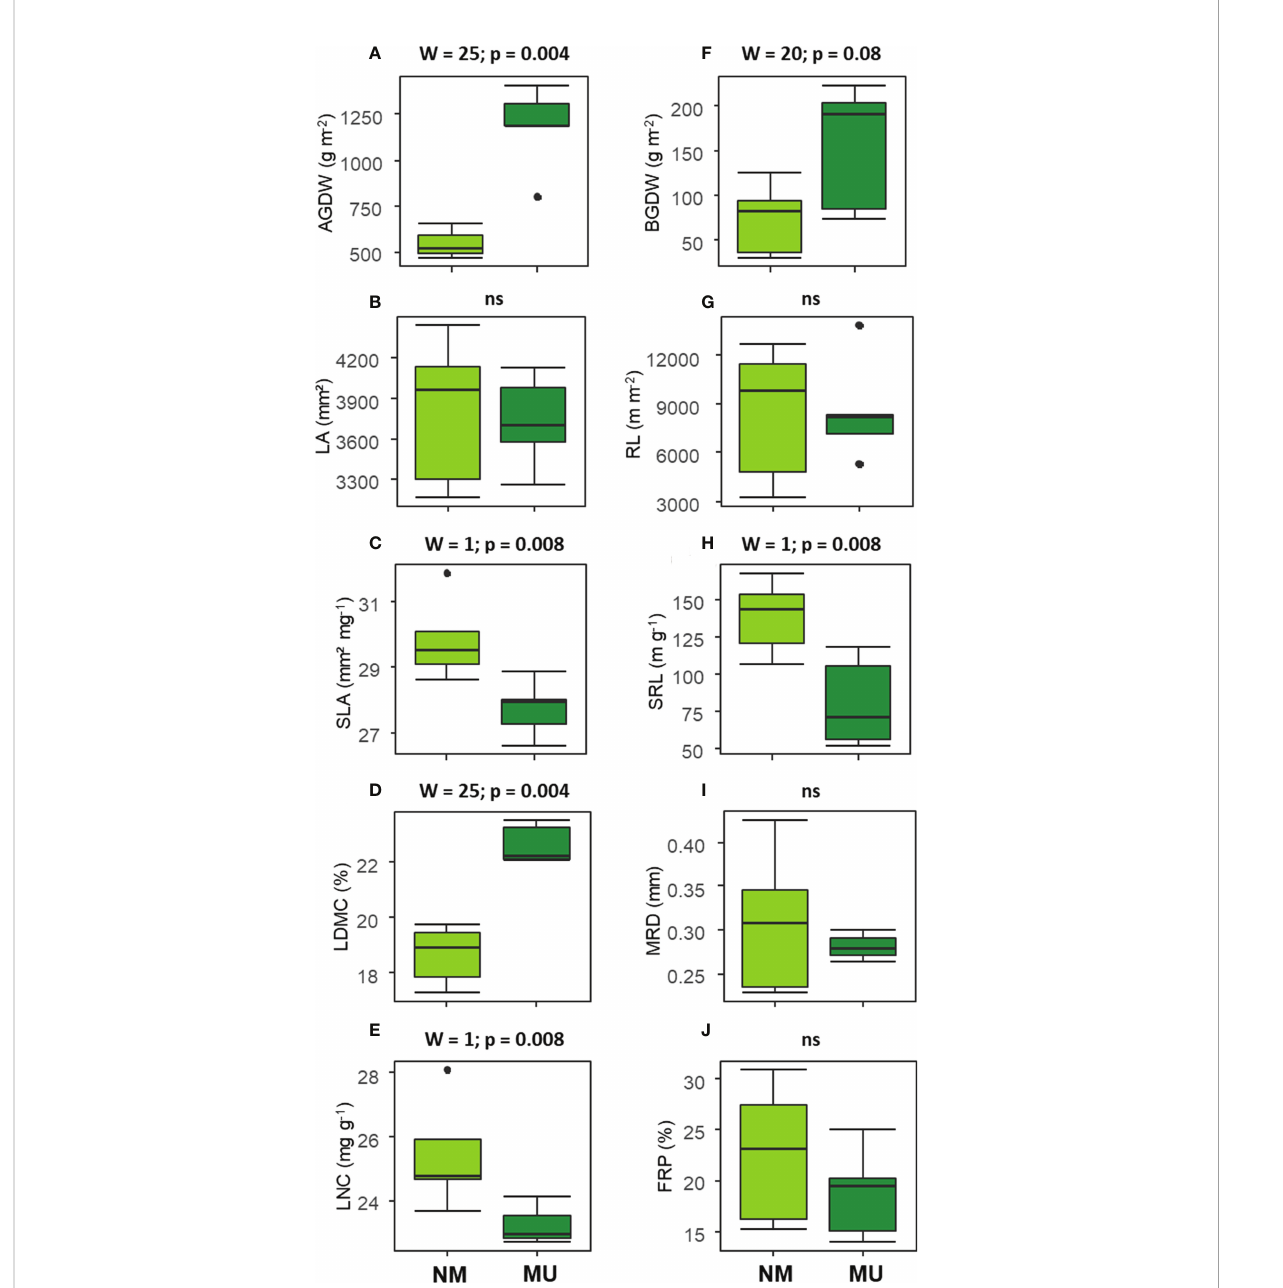
FIGURE 3 Comparison of the community-level above- (A – E) and below-ground traits (F – J) between control (NM; no mulching) and mulching (MU) in the 10 sampling plots. The boxplot indicates the median (line in the middle of the boxes), the interquartile range (boxes), 1.5 times the interquartile range (whiskers) and outliers (circle). Results of the Wilcoxon test are reported in each sub fi gure; ns, not signi fi cant (p > 0.1). AGDW and BGDW, above- and below- ground dry weight, FRP, fi ne-root percentage, LA, community weighted mean (CWM) of leaf area, LDMC, CWM of leaf dry matter content, LNC, CWM of leaf nitrogen content, MRD, mean root diameter, SLA, CWM of speci fi c leaf area, SRL, speci fi c root length, RL, root